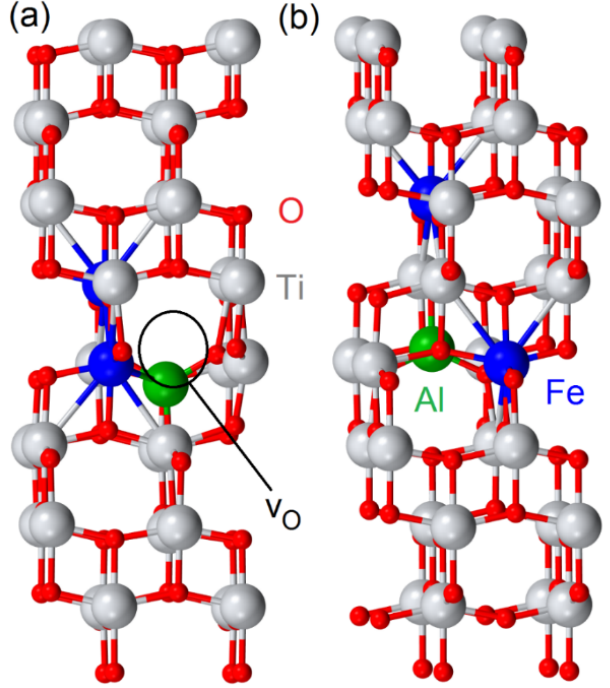
Figure 1. Optimized atomic structures of the most energetically favorable configurations of substi- tutional Fe-impurities in the vicinity of Al-impurity in interstitial void in TiO 2 matrix with ( a ) and without ( b ) oxygen vacancy.